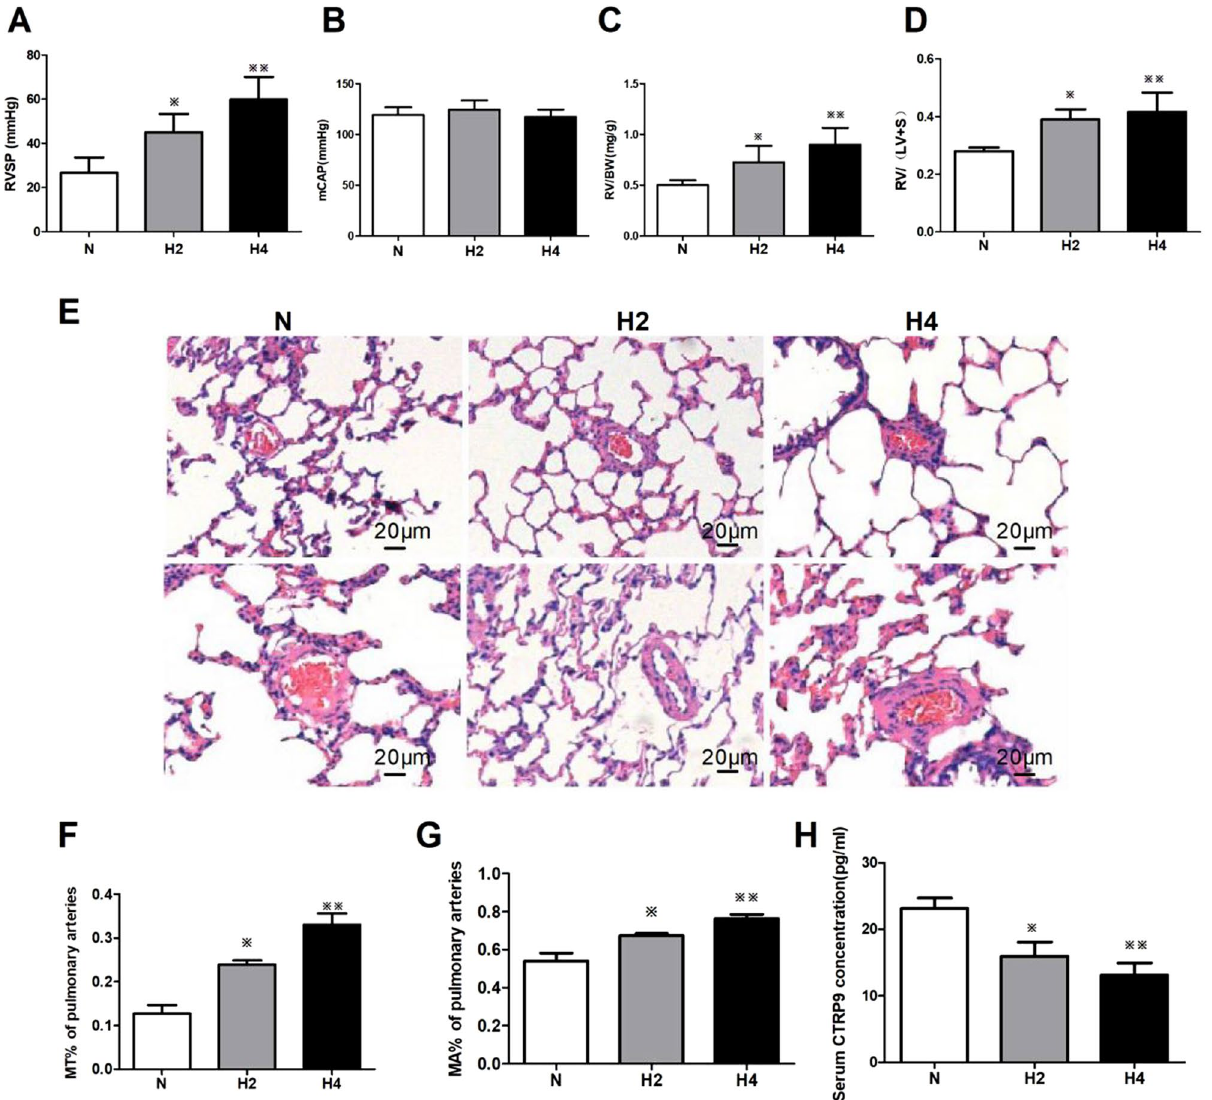
Figure 1. Hypoxia induced cardiopulmonary remodeling and reduction of serum CTRP9 content in rats. ( A – D ) Quantitative data of cardiopulmonary hemodynamics, including right ventricular systolic pressure (RVSP, A ), mean carotid artery pressure (mCAP, B ), and right ventricular hypertrophy index ( C , D ), are presented. € Paraffin-embedded sections of rat lungs were assessed for pulmonary arterial remodeling by staining (hematoxylin & eosin; × 200 magnification). Scale bar = 20 μm. ( F , G ) Blinded quantitative analyses of MT% and MA% of peripheral pulmonary arteries (30 vessels/3 sections from one animal, 30–100 μm in diameter) were done using Image-Pro Plus. ( H ) CTRP9 concentrations in the serum of rats suffering hypoxia or not (n = 6). Data are the mean ± SEM. P < 0.05, P < 0.01 vs. normoxia group. N normoxia for 4 weeks, H2 hypoxia for 2 weeks, H4 hypoxia for 4 ※ ※※ ( P < 0.05), compared with those in group N + AAV-Control. Interestingly, in group H + AAV-CTRP9, the NO concentration was increased ( P < 0.01) and ET-1 concentration was reduced ( P < 0.05) compared with those in group H + AAV-Control. These results suggested that hypoxia could disturb the production of NO and ET-1, and that CTRP9 could regulate such hypoxia-induced production. Hence, CTRP9 could ameliorate HPH by protecting the endothelium. To investigate the potential mechanisms of action, expression of the upstream signaling molecules 5 ′ -adeno- sine monophosphate-activated protein kinase (AMPK) and p-AMPK (phosphorylated at Thr 172 of its α subunit), eNOS and p-eNOS (phosphorylated at Ser 1177 ), ERK1/2 and p-ERK1/2 (phosphorylated at Thr 202 /Tyr 204 ) was determined in isolated pulmonary microvascular endothelial cells (PMVECs). Total expression of AMPK, eNOS and ERK1/2 did not vary among the four groups (Fig. 4A–C). In group H + AAV-Control, expression of phos- phorylated AMPK and eNOS was reduced, whereas that of phosphorylated ERK1/2 increased compared with those in group N + AAV-Control. In group H + AAV-CTRP9, phosphorylation levels of AMPK and eNOS was